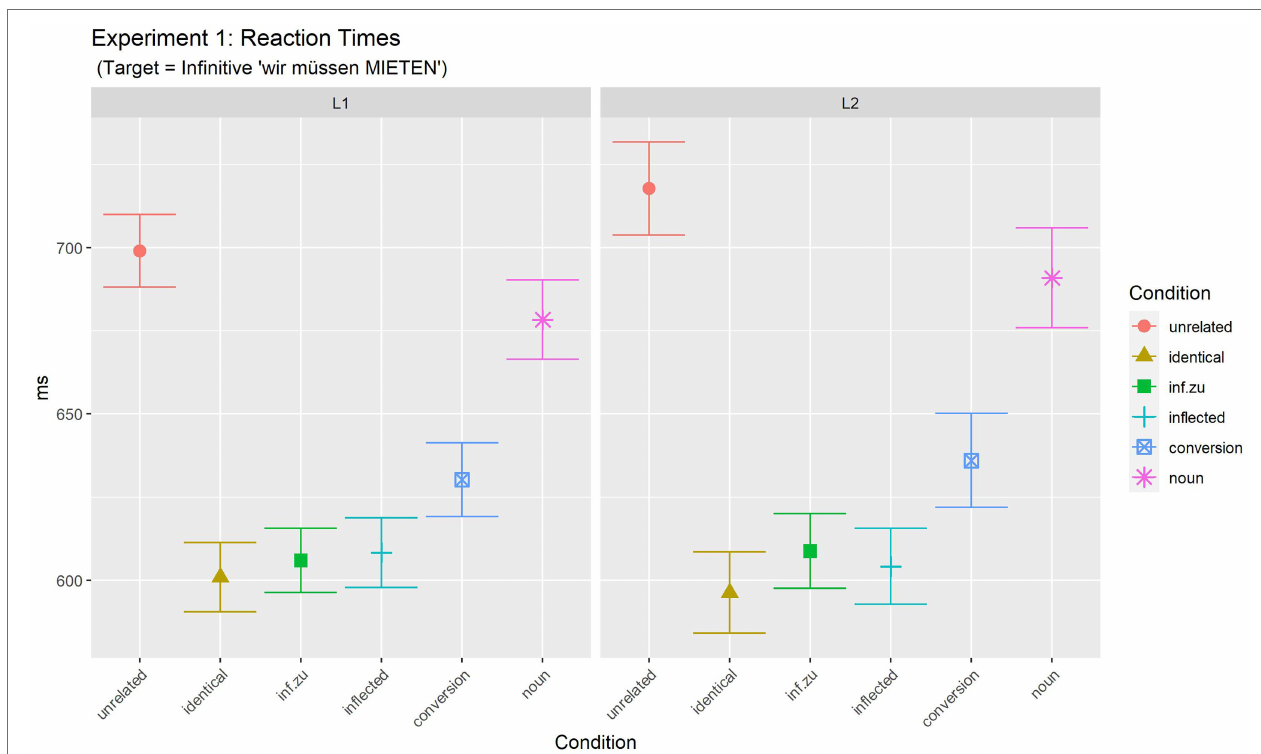
FIGURE 1 | Experiment 1 (target: infinitive): mean reaction times for target